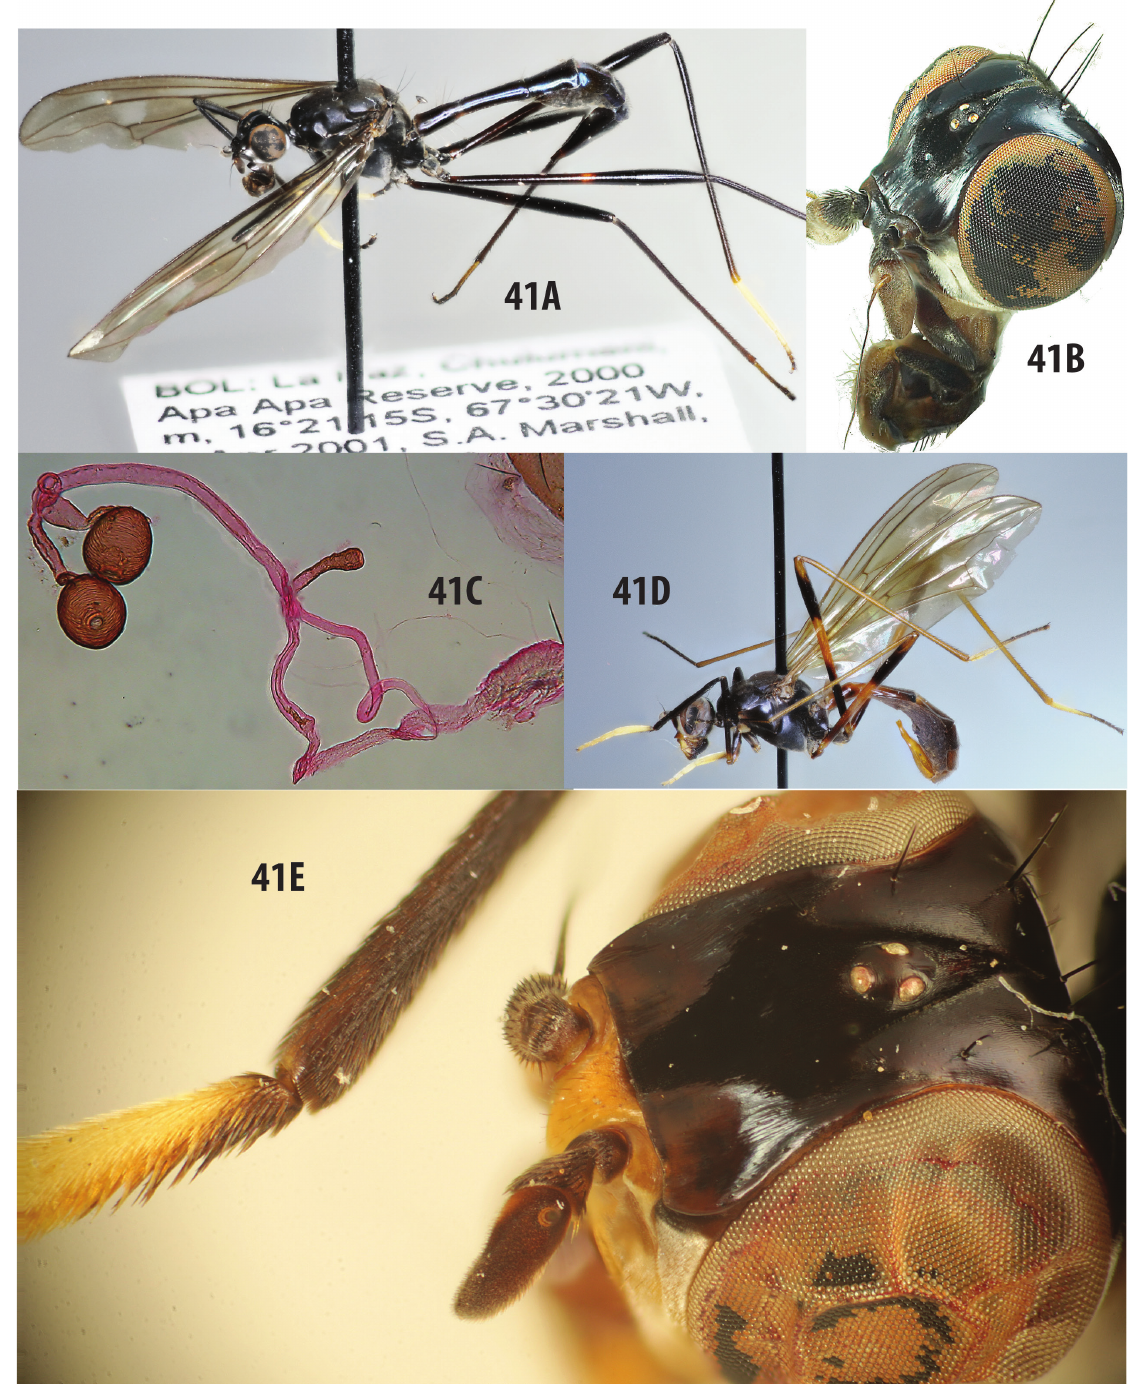
Fig. 41. A–B . Mesoconius apa sp. nov., holotype, ♀, CBFC. A . Habitus. B . Head. — C–E . M. apicalis sp. nov., holotype, ♀, QCAZ. C . Spermathecae and associated structures. D . Habitus. E . Head and apex of fore